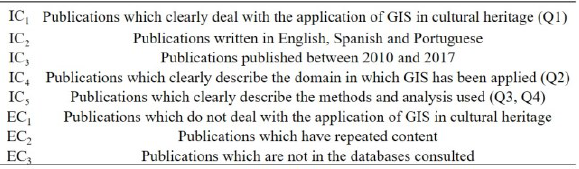
Table 02: Definition of the Inclusion (IC) and exclusion criteria (EC) for the qualitative review.